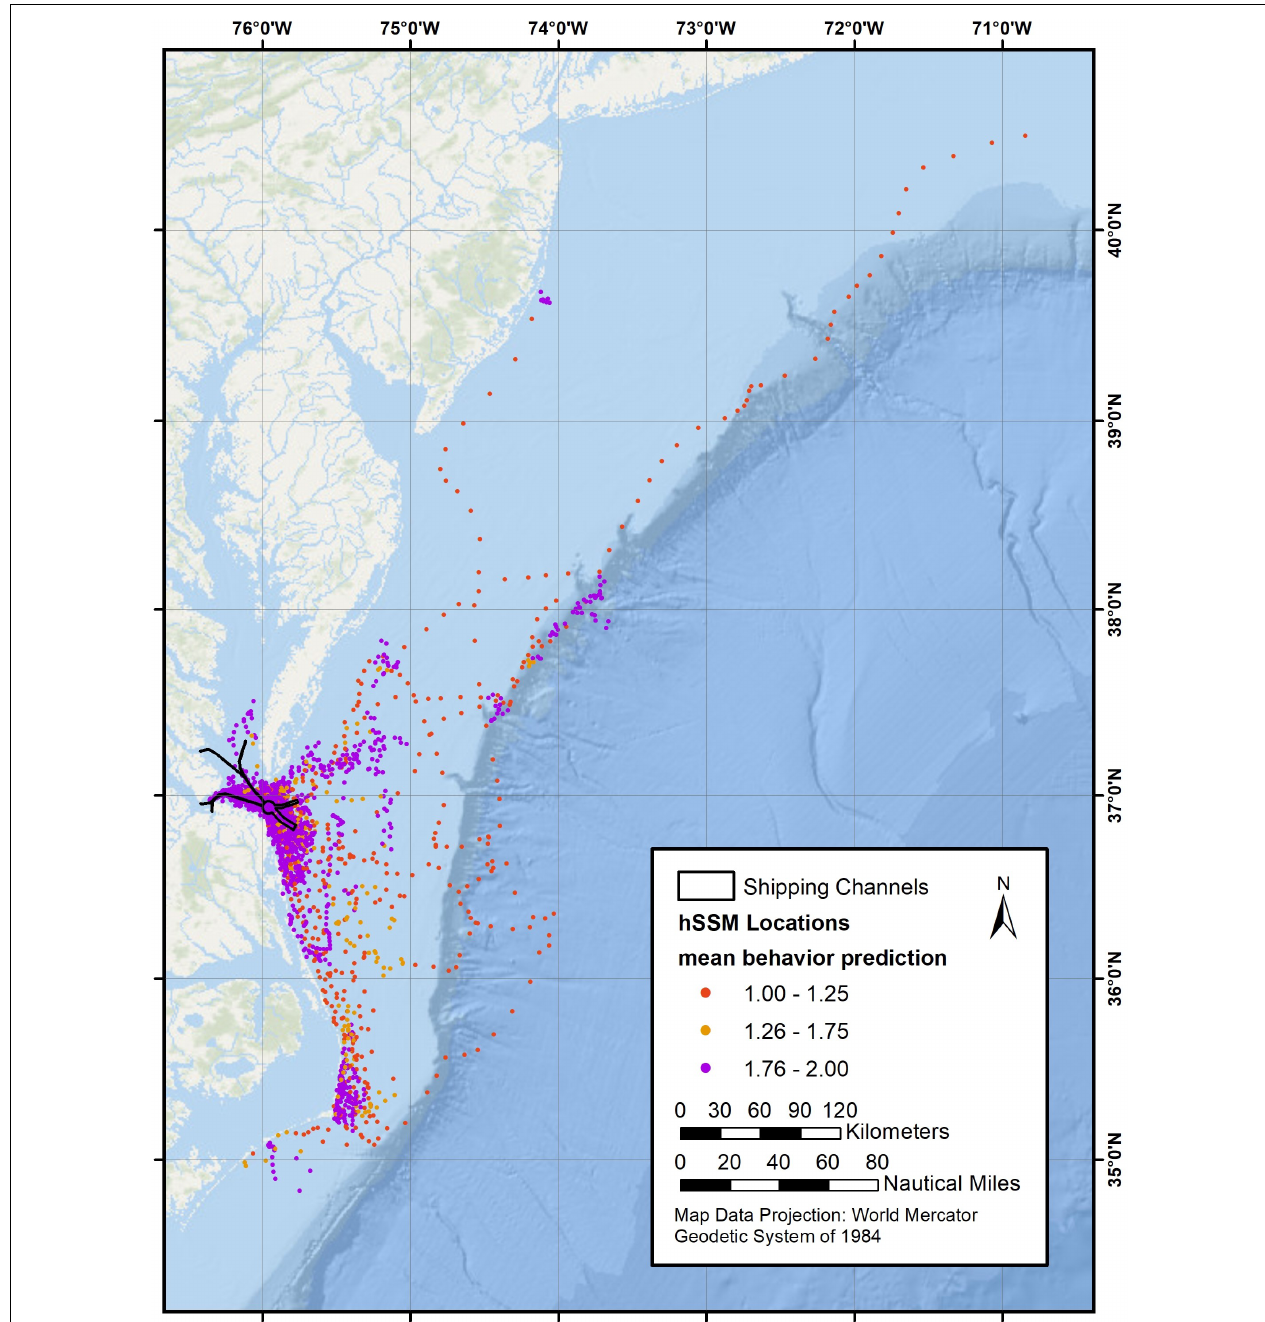
FIGURE 5 | Mean predicted behavioral state from the hSSM for 33 tagged whales along the eastern seaboard from Cape Hatteras, North Carolina to Long Island, New York, showing travel (red dots), area-restricted search (purple dots), and indeterminate behavior (orange